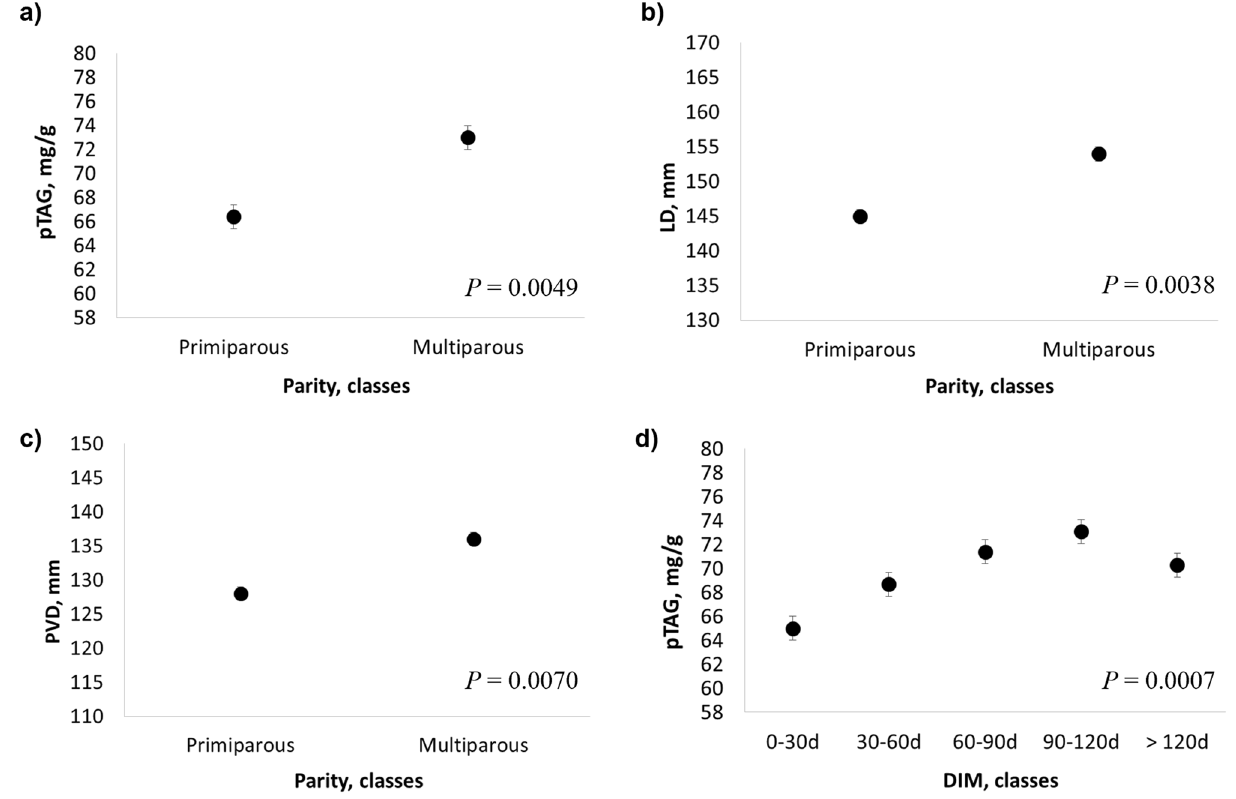
Figure 1. Least squares means (LSM) for ( a , d ) predicted liver triacylglycerol (pTAG), ( b ) portal vein depth (PVD) and ( c ) liver depth (LD) across parity and days in milk (DIM) classes. Black dots indicate the LSM and error bars indicate the standard